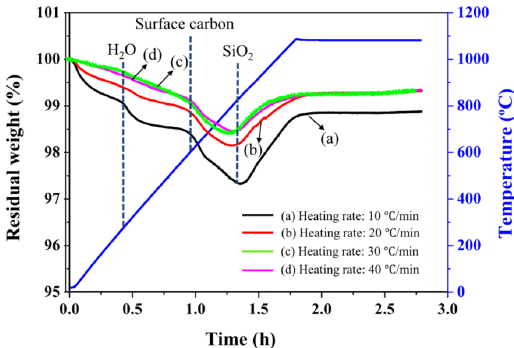
Fig. 9 Oxidation resistance test of after-pyrolysis SiC fiber at different heating rates using TGA